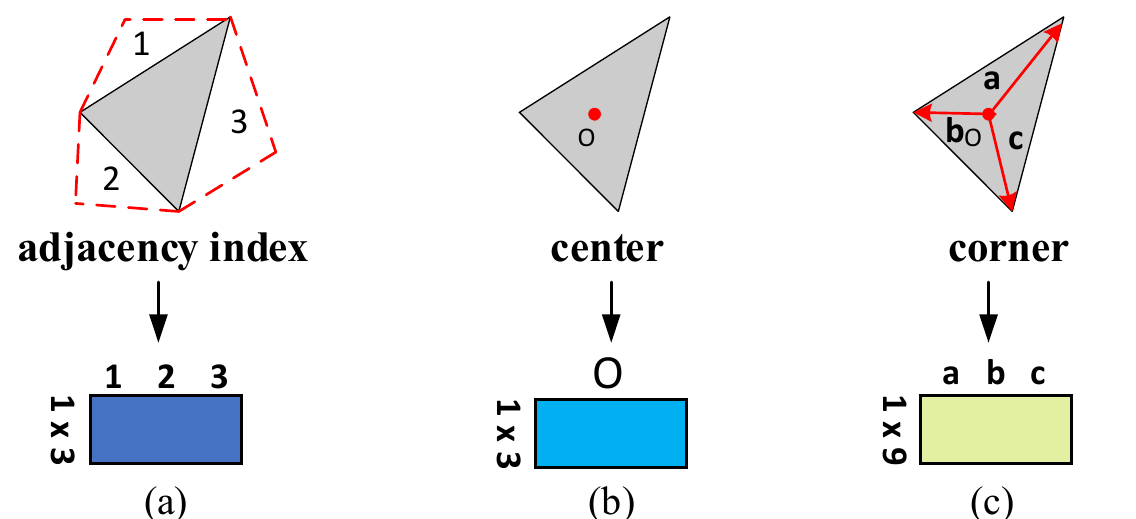
Figure 3. Initial feature extraction: ( a ) indexing of adjacent faces; ( b ) coordinates of the center point